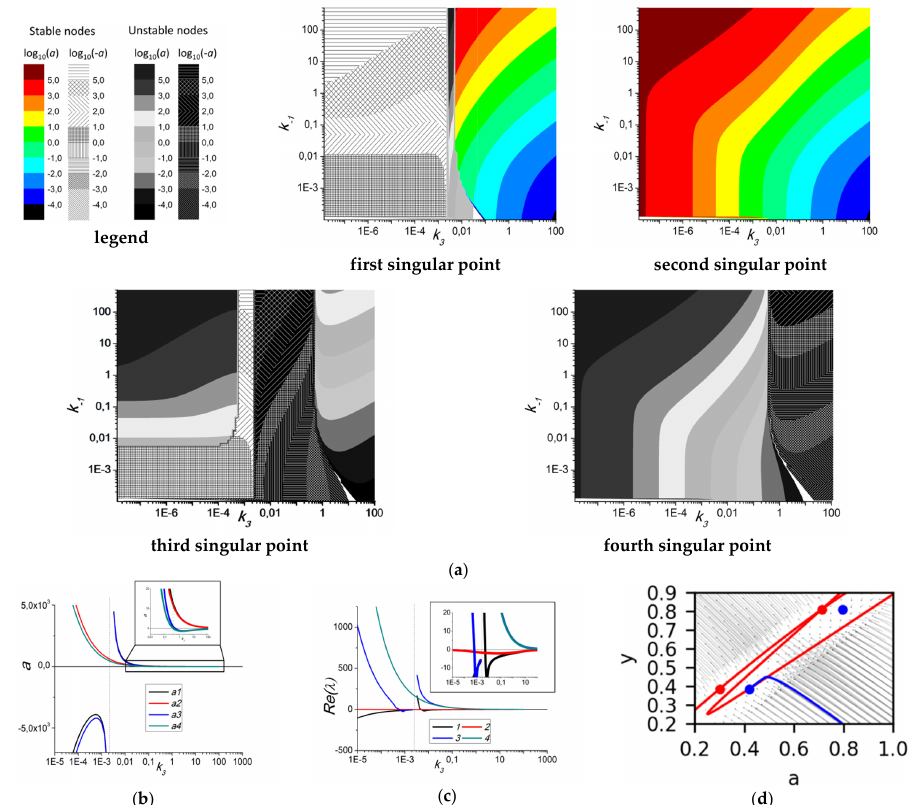
Figure 5. Numerical investigation of the parameter space for ADP = 2.5 μ M . ( a ) Typical bifurcation diagrams demonstrating an area with 4 singular points (log 10 ( a ) as a function of k − 1 and k 3 , other parameters were set at 0.49 ( k 1 ), 0.067 ( k 2 ), 0.026 ( k − 3 ). It can be seen that all four singular points exist for almost any combination of parameters. However, the third and fourth points are always “unstable”, while the second is always stable and positive, and the first could be either stable or unstable. ( b , c ) Bifurcation diagrams for the values of a ( b ), inset show the value of k 3 for which 4 singular points with positive values of a exist) and the real part of the first eigenvalue of Jacobian ( c ), inset shows a close up view near Re( λ ) = 0), k 3 is varied, k − 1 = 5, k 1 = 0.49, k 2 = 0.067, k − 3 = 0.026. Together, ( b , c ) demonstrate the existence of two “stable nodes” (first and second) with positive values of a for a subspace of parameter space. At k 3 = 0.0025, a “stable node”–“unstable node” bifurcation happens for the second singular point (black lines). ( d ) Phase plane for the system with the following parameter set: k − 1 = 0.05, k 1 =4.93, k 2 = 0.675, k 3 = 0.1, k − 3 = 0.026. Nullclines are given in red, trajectories from point { a,y } = {1,0} into steady state are given in blue. Stable singular points are given in blue, unstable singular points are given in red, directions of phase trajectories are shown in grey.